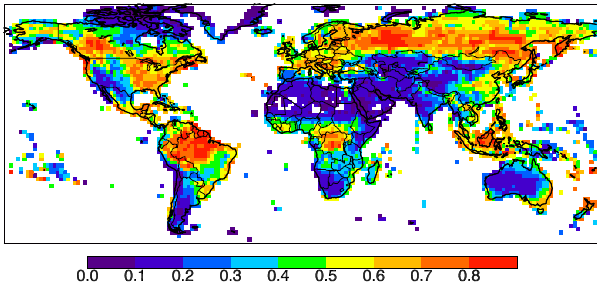
Fig. 8. MODIS FPAR product (unitless) for 20–27July 32